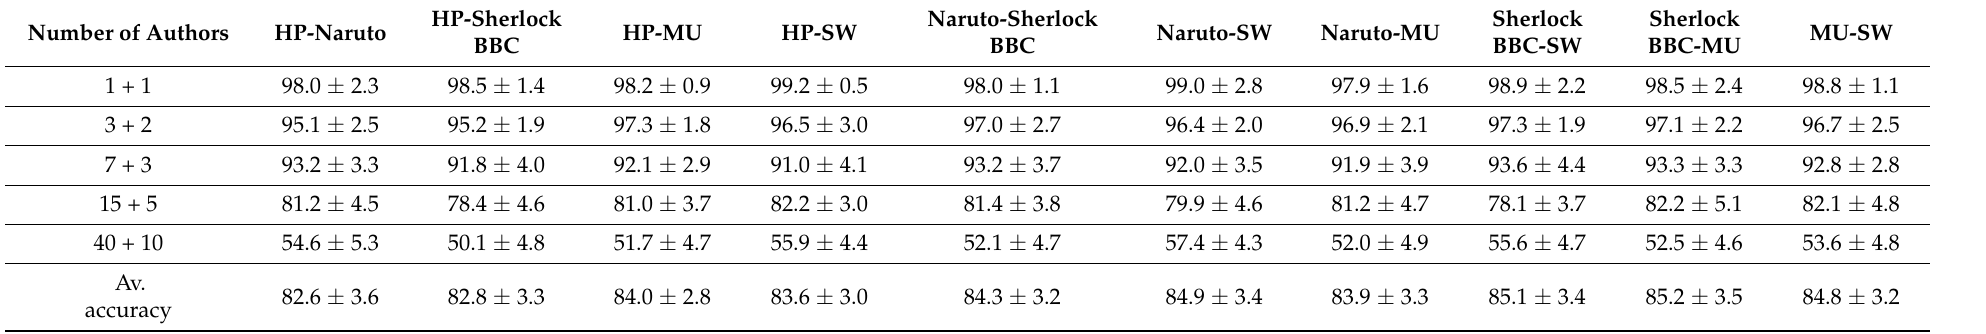
Table 11. Method based on SoftMax thresholding using fastText for cross-topic